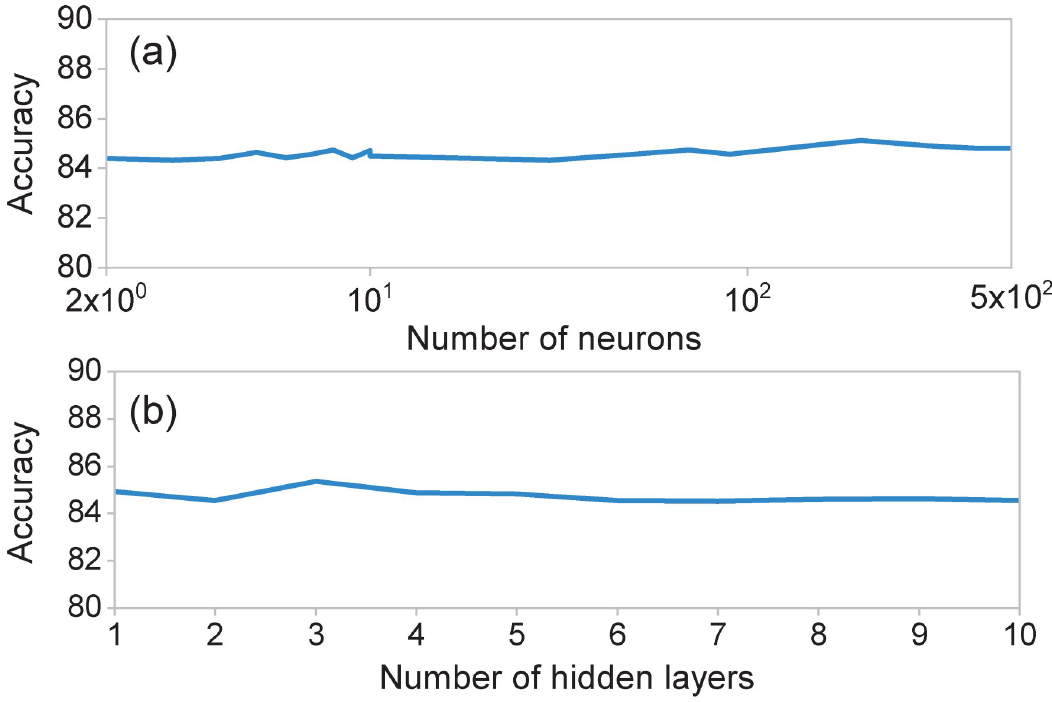
Fig 9. Overall accuracy of the neural network for the identification of high-risk COVID-19 patients, at the first clinical stage, as a function of (a) the number of neurons in the hidden layer and (b) the number of hidden layers. In the last case, the number of neurons in each layer was set to